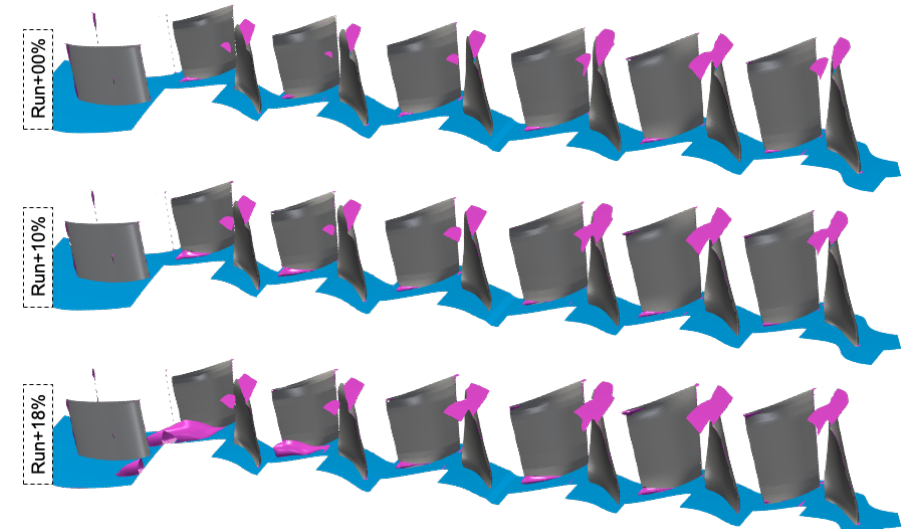
Figure 10. View of stages 10 to 15 + OGV; recirculating flow regions are highlighted by iso-surface of zero axial velocity (flow goes from right to